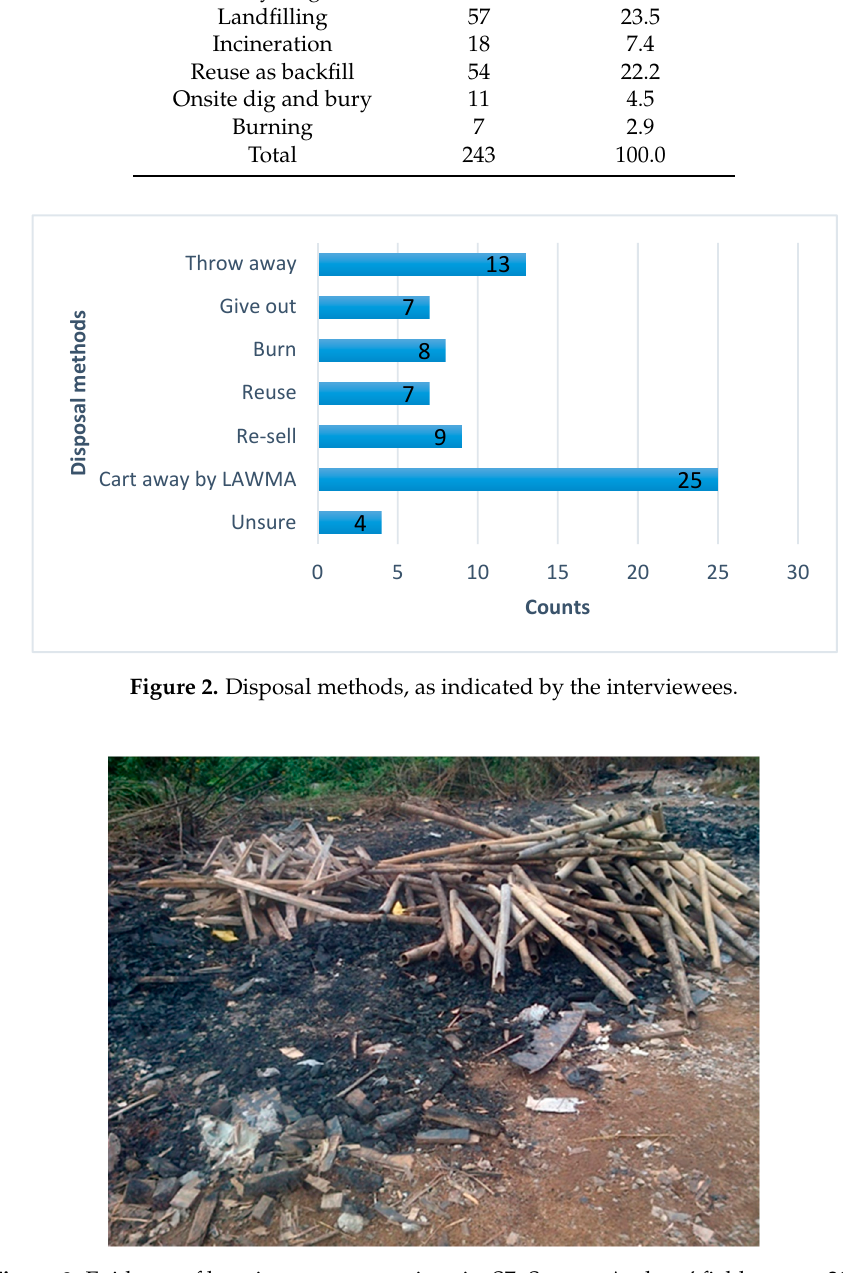
Figure 3. Evidence of burning on construction site S7. Source: Authors’ field survey, 2017 .